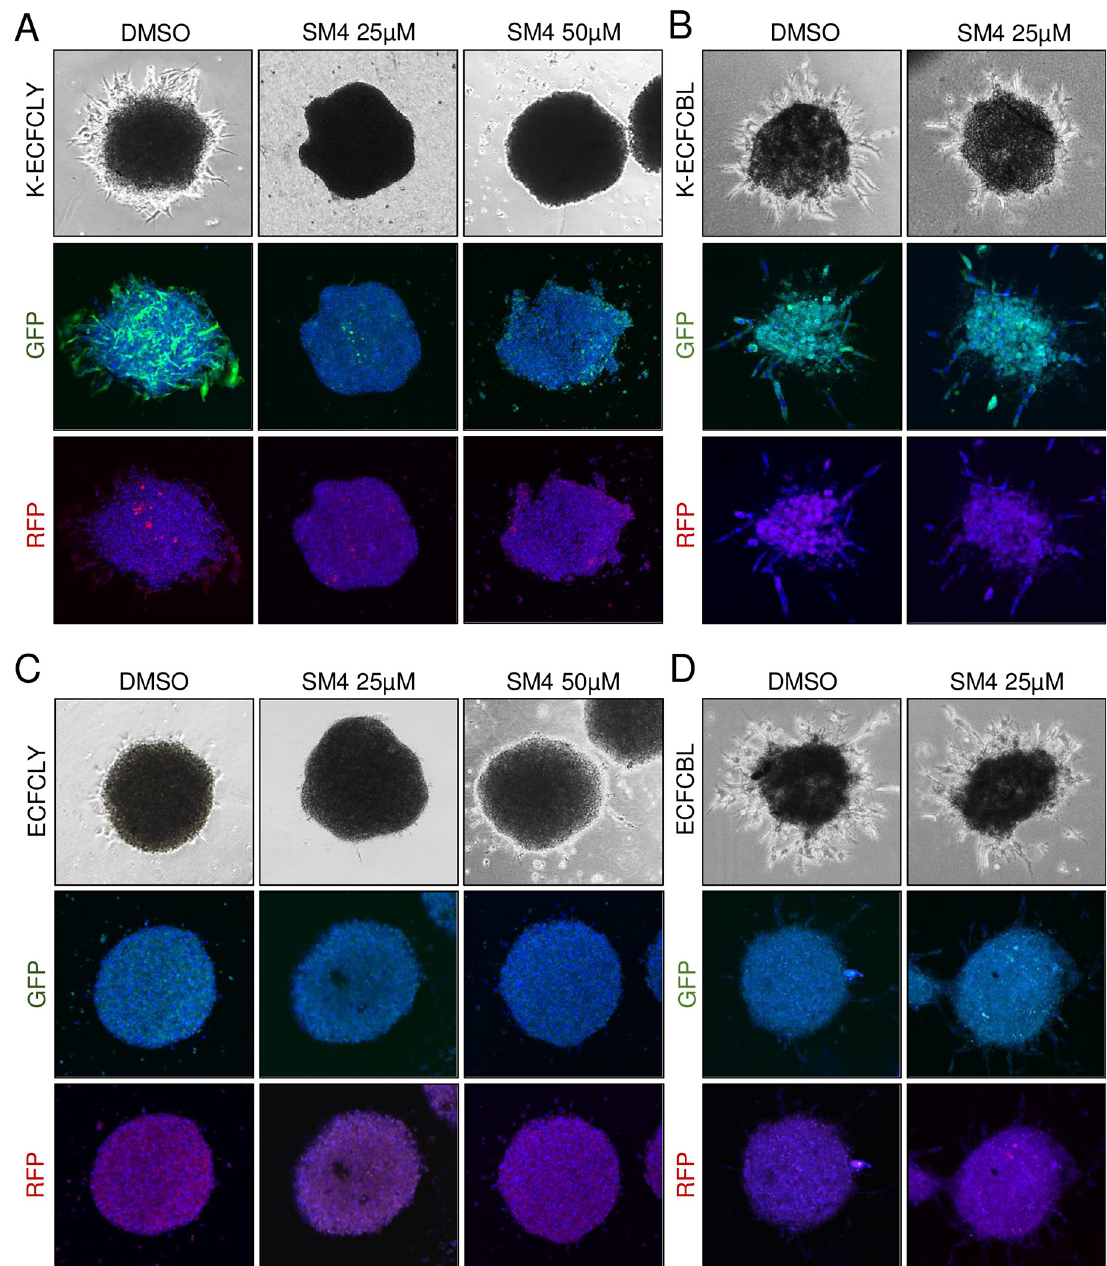
Fig 5. SOX18 inhibition reduces the KSHV-induced sprouting in lymphatic ECFCs. Lymphatic ( A and C ) and blood ( B and D ) ECFCs were either mock or KSHV-infected, allowed to form spheroids overnight and then embedded in 3D fibrin. Spheroids were treated for six days with either 25uM or 50 μ M of SM4, and the highest DMSO concentration control, fixed and imaged. Phase contrast of live spheroids and confocal images of fixed and stained spheroids are shown at treatment day 6. These images do not necessarily always represent the same